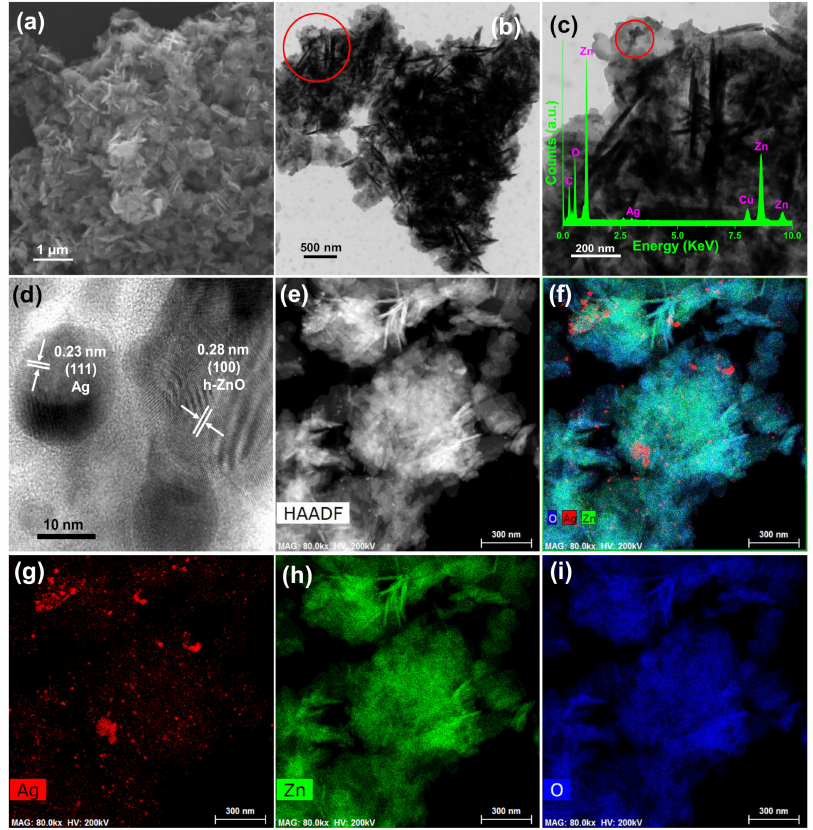
Figure 2. ( a ) FESEM image of as-prepared ZO sample. ( b , c ) Transmission electron microscopy (TEM) images of AZO sample. ( c ) Enlarged TEM image of AZO sample from the marked portion of ( b ) with ( c inset) TEM-energy-dispersive X-ray spectrum, ( d ) high-resolution TEM image of the AZO sample from the marked portion of ( c ), High-angle annular dark-field (HAADF) image (e), and elemental mappings of ( f ) composite, ( g ) Ag, ( h ) Zn, and ( i )